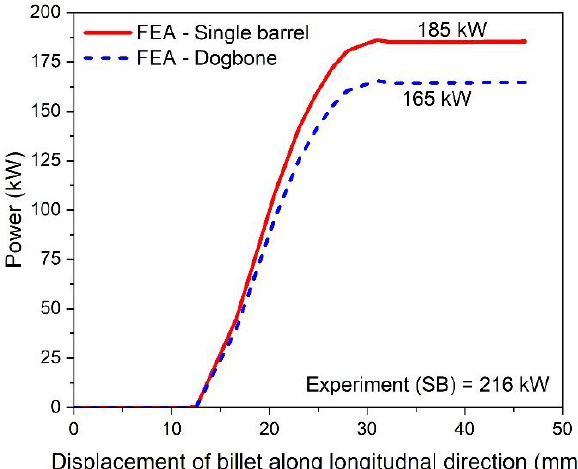
Figure 15. Power requirement for single and double barrels.